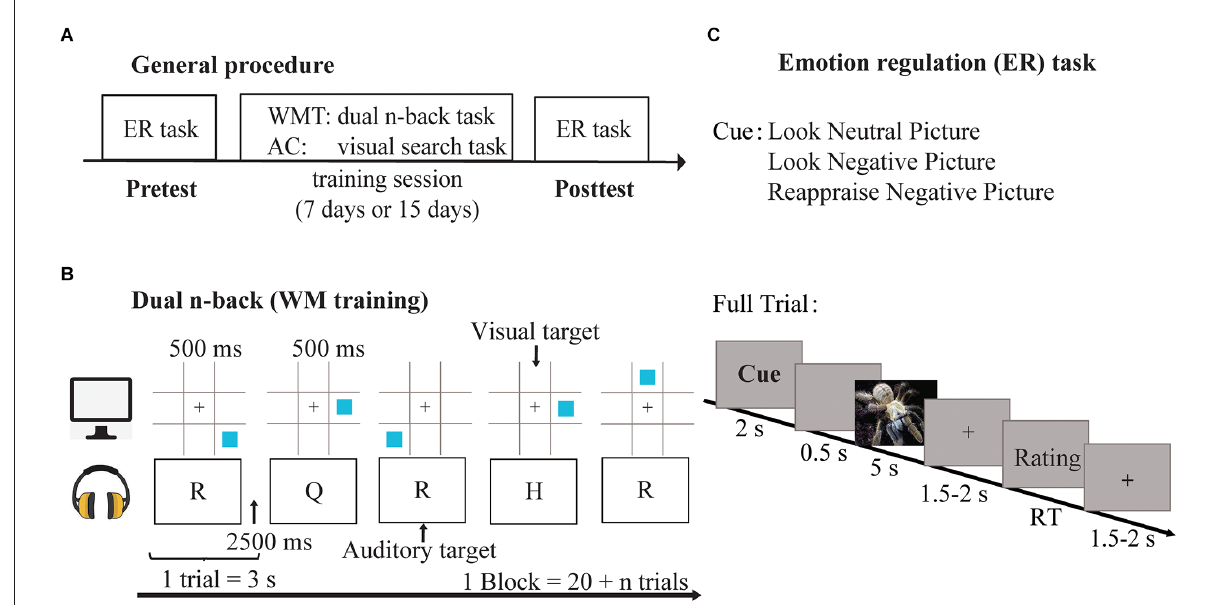
FIGURE1 General procedure (A) and experimental tasks for Experiments 1 and 2. Task design for WM training, illustrated by a dual n -back condition, presented the visual stream at the same rate as the auditory stream (B) . Task design of emotion regulation (C)